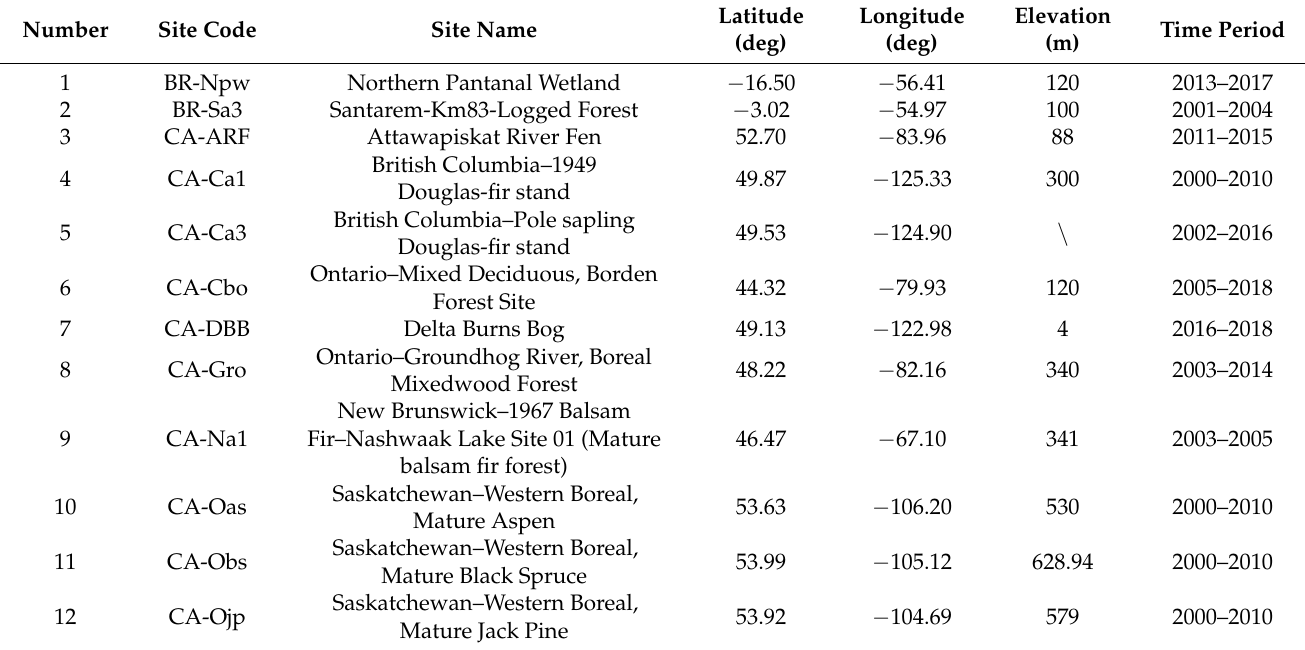
Table A1. Detailed information of the ground